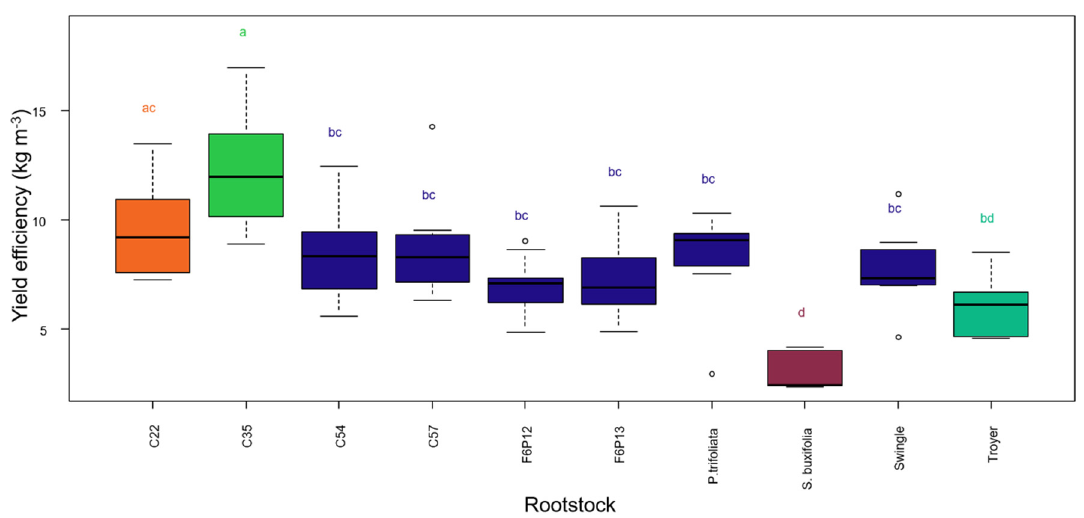
Figure 5. Yield efficiency of Mandared grafted onto 10 rootstocks. Different letters indicate significantly different means according to Tukey’s test at p < 0.05. Different colors of the boxes indicate different significance groups.